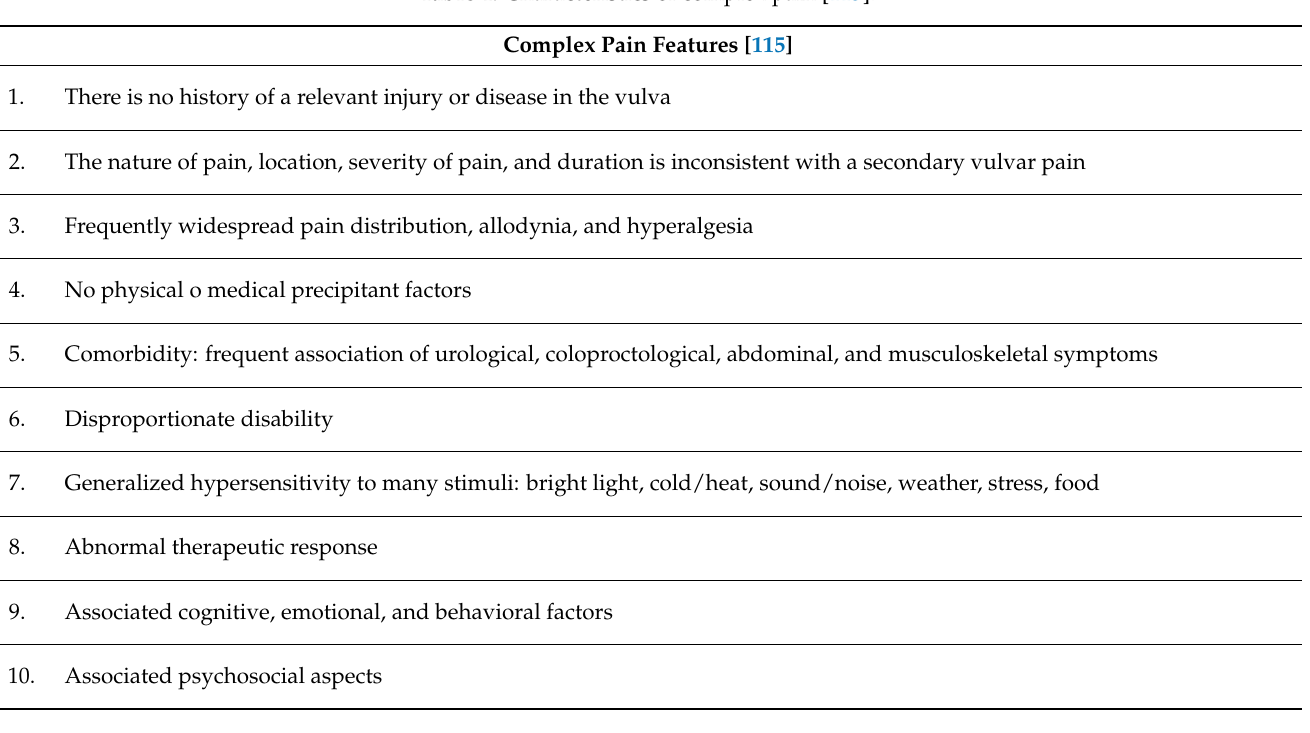
Table 4. Characteristics of complex pain